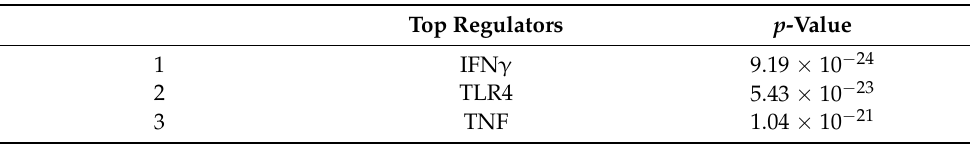
Table 1. The top upstream transcriptional regulators in high-fat-diet mice, determined by the Ingenuity ® Knowledge Base.